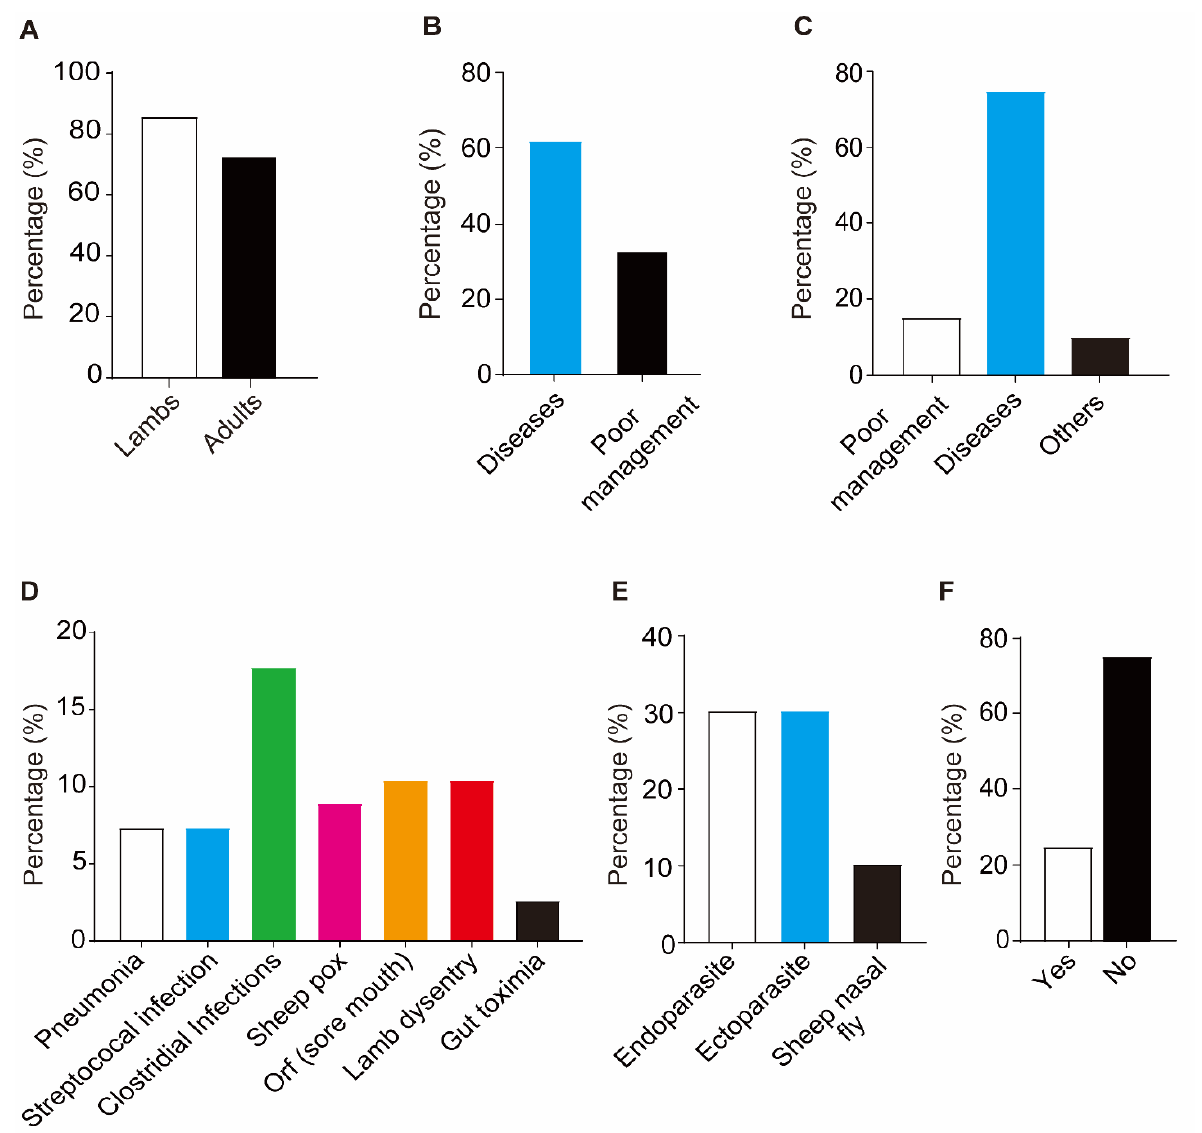
Figure 4. The health status. ( A ) Percentage of lambs and adults that survived. ( B ) Major causes of mortality in lambs. ( C ) Major causes of mortality in adults. ( D ) Prevalence of infectious diseases. ( E ) Prevalence of parasitic diseases. ( F ) Vaccination practices.